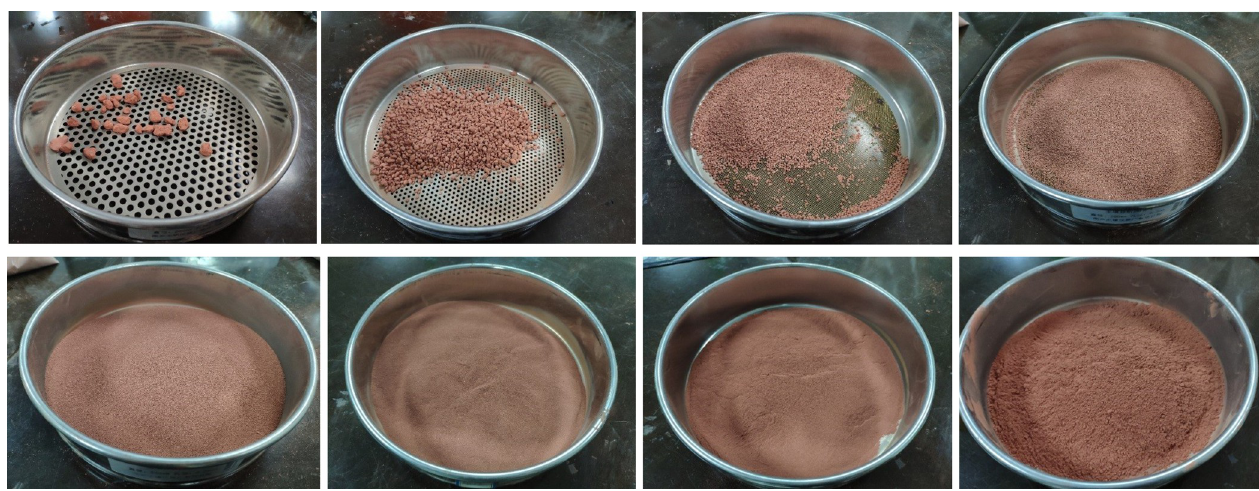
Fig 4. Naturally weathered red-bed soil particles corresponding to each particle size (A) > 5 mm; (B) 2–5 mm; (C) 1–2 mm; (D) 0.5–1 mm; (E) 0.25–0.5 mm; (F) 0.1–0.25 mm; (G) 0.075–0.1 mm; (H) < 0.075 mm.